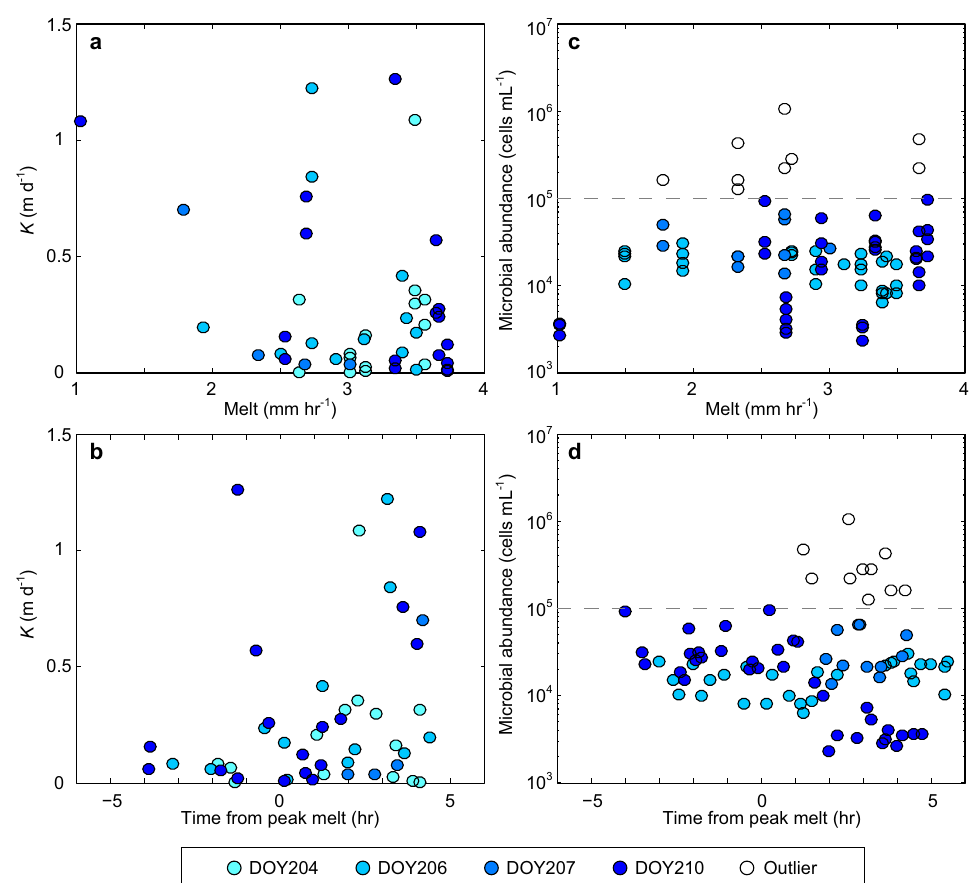
Fig. 3 Scatter plots comparing melt conditions, near-surface hydraulic conductivity and microbial abundance. a Relationship between hydraulic conductivity ( K ) and coincident melt. b Association between K and time relative to peak melt. c Scatter plot of microbial abundance and coincident melt. d Scatter plot of microbial abundance and time relative to peak melt. Sample points are grouped and shaded according to the day of year (DOY) collection date, and those assessed as outliers, with >1 × 10 5 cells mL − 1 (see Methods), are shown with hollowed markers above a dashed